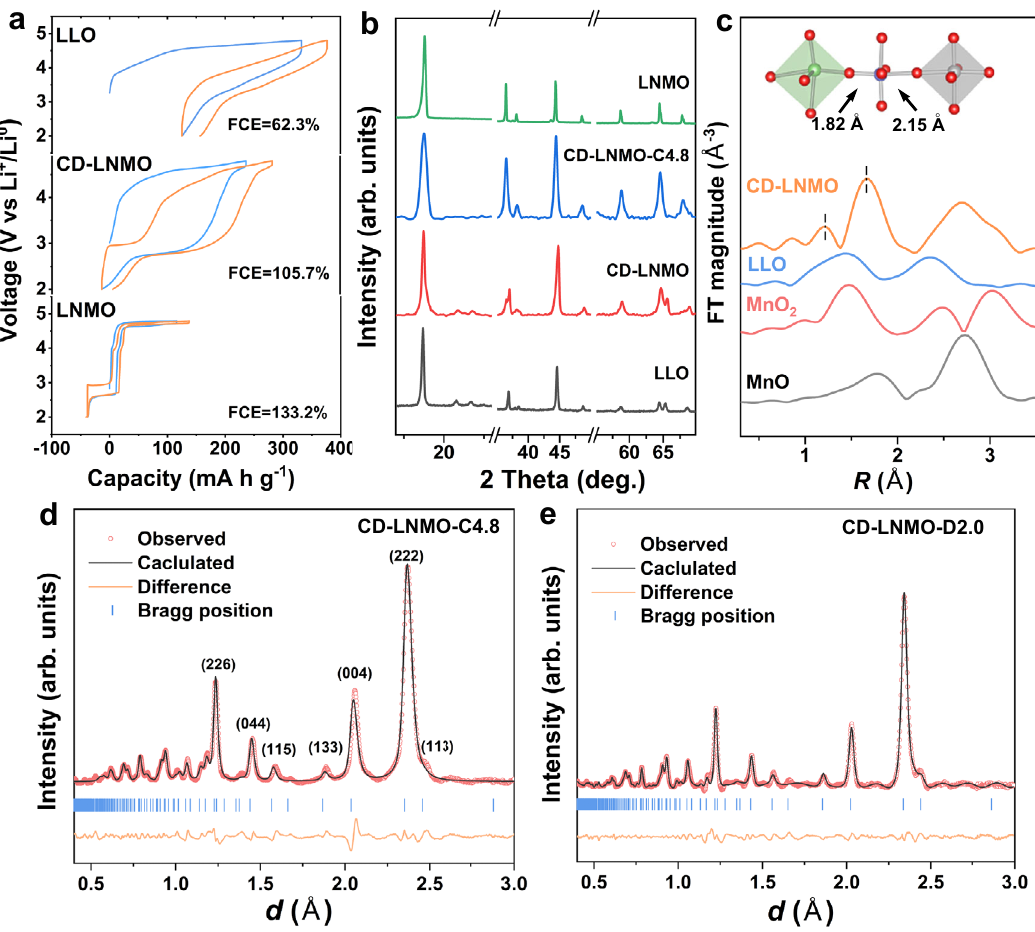
Fig. 2 | Electrochemical and structural characterization of different lithium transition metal oxide materials. a Comparison of the fi rst two cycle voltage pro fi les of LLO, CD-LNMO, and LNMO from 2.0 – 4.8V. The tests were performed with a speci fi c current of 100mAg − 1 at 25±5°C. b Synchrotron X-ray (SXRD) pat- terns of CD-LNMO and fully charged CD-LNMO (denoted as CD-LNMO-C4.8). The laboratory XRD patterns of LLO and LNMO are shown as references. Both the synchrotron and laboratory X-ray measurements were performed under the wavelength of Cu radiator (1.54Å). c k 3 -weighted Fourier transform magnitudes of Mn K-edge EXAFS spectra obtained from LLO and CD-LNMO. Mn K-edge EXAFS spectra of MnO and MnO 2 are shown as references. The short and long fi rst-shell